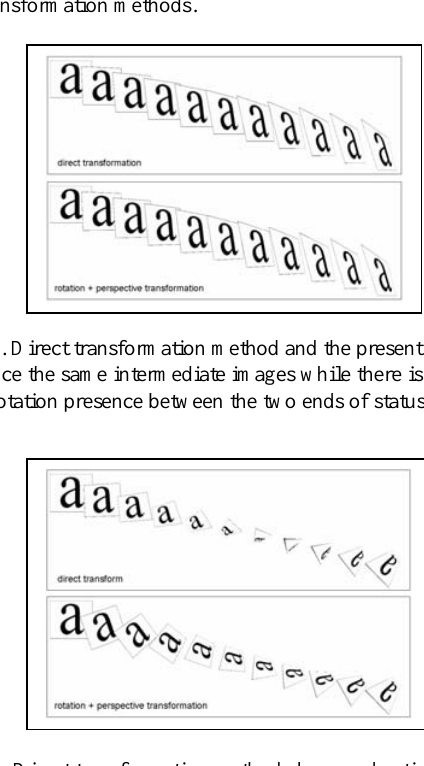
Figure 8. Direct transformation method changes drastically the shapes of intermediate images if there is a rotation angle present, while the present method generates a smooth interpolation